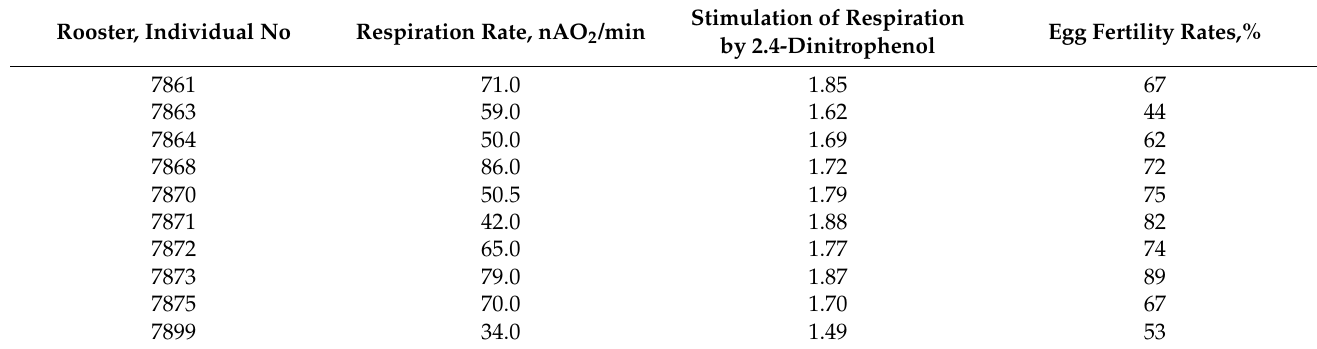
Table 4. Respiration activity in rooster semen and egg fertility